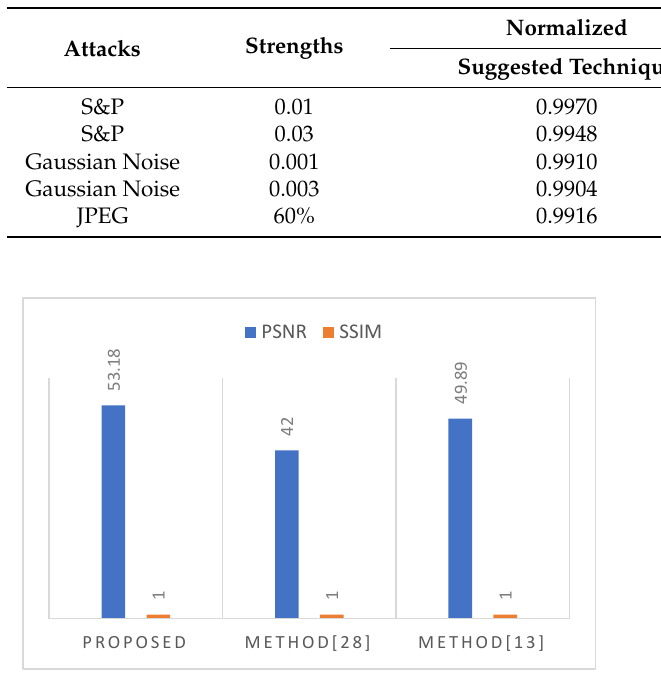
Figure 7. PSNR and SSIM comparison.